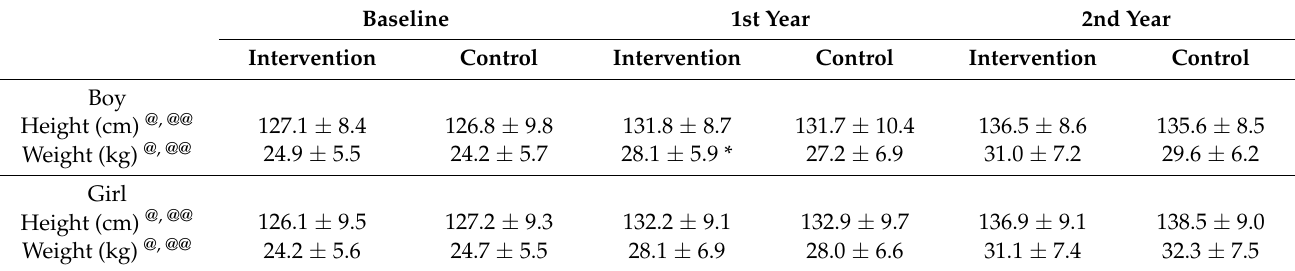
Table 4. Comparison on height and weight between intervention group and control.